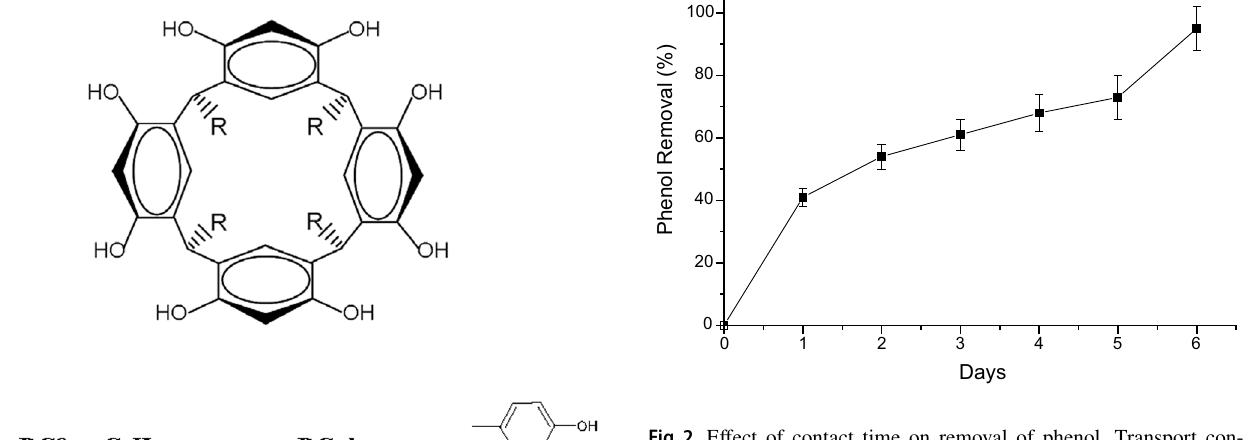
Fig. 2 Effect of contact time on removal of phenol. Transport con- ditions: feed phase: phenol 10 −3 M, pH 2. Stripping phase: NaOH 0.20 M. Membrane: 12.60 cm 2 of surface area, calix[4]resorcinarene: RC8 (0.15 g/g mixture of polymers), 0.03 ml 2-NPOE/g